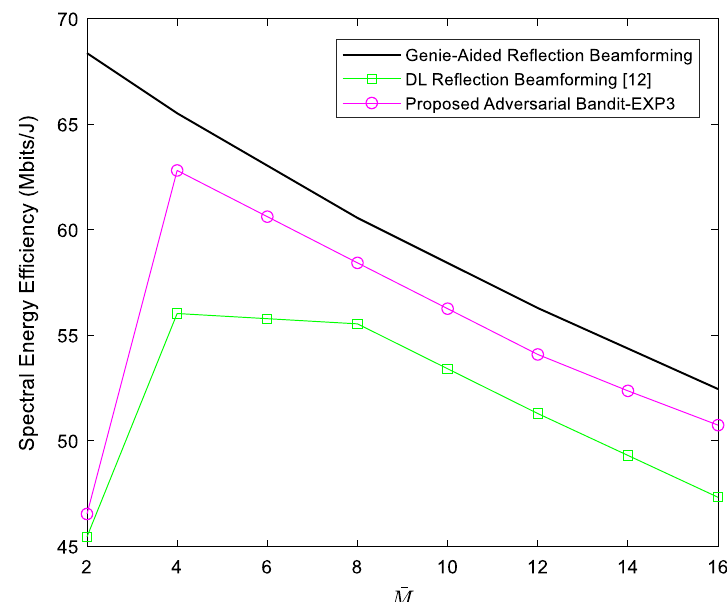
Fig. 5 The energy efficiency η versus the number of active elements M of the proposed EXP3-based scheme in comparison with the reference DL reflection beamforming [26] and the reference genie-aided method where the number of training data is set to 30